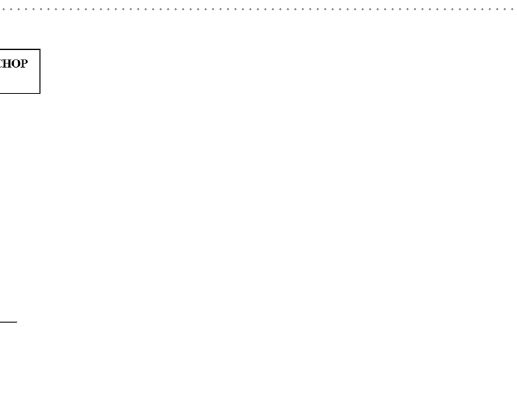
Figure 5. ROS-dependent ER stress was involved in the TNT-mediated ROS production. ( A ) HepG2 cells were treated with 80 μ M TNT for 24 h in the presence or absence of 10 mM NAC, given the expression of ER stress-related proteins. The bands were excised from different gels that were run under the same electrophoresis condition. ( B ) The cells were treated with 0–100 μ M TNT for 24 h in the presence or absence of 10 mM NAC, and then the cell viability was determined. The values represent the mean ± SD and were derived from at least three independent experiments. Triplicate measurements were performed for each experiment. ** P < 0.01 (vs. control cells).